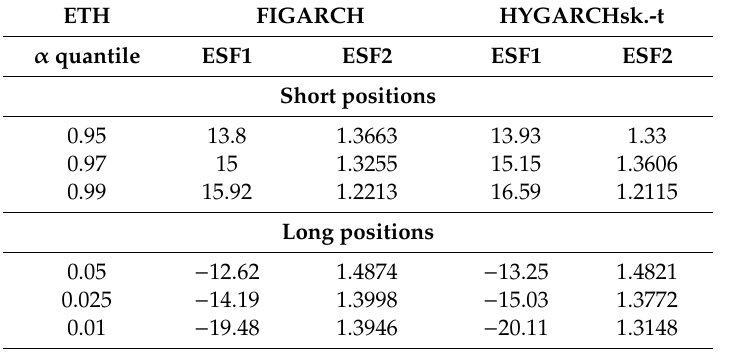
Table 7. In-sample Value-at-Risk (VaR) Expected Shortfalls. Panel A: Expected Shortfalls for Bitcoin (BTC). BTC HYGARCH